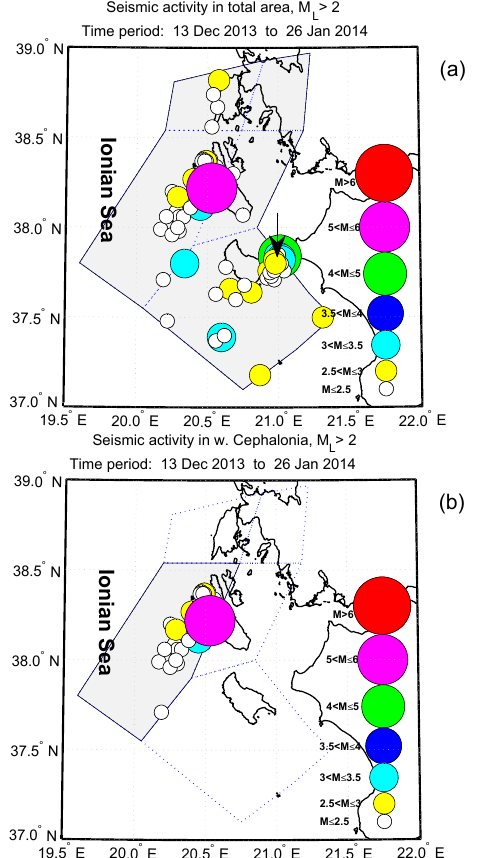
Figure 9. Foreshock seismic activity ( M L ) before EQ1: (a) for the whole investigated area of the Ionian Sea region; (b) for western Cephalonia. (For an interpretation of the references to colours, the reader is referred to the online version of this